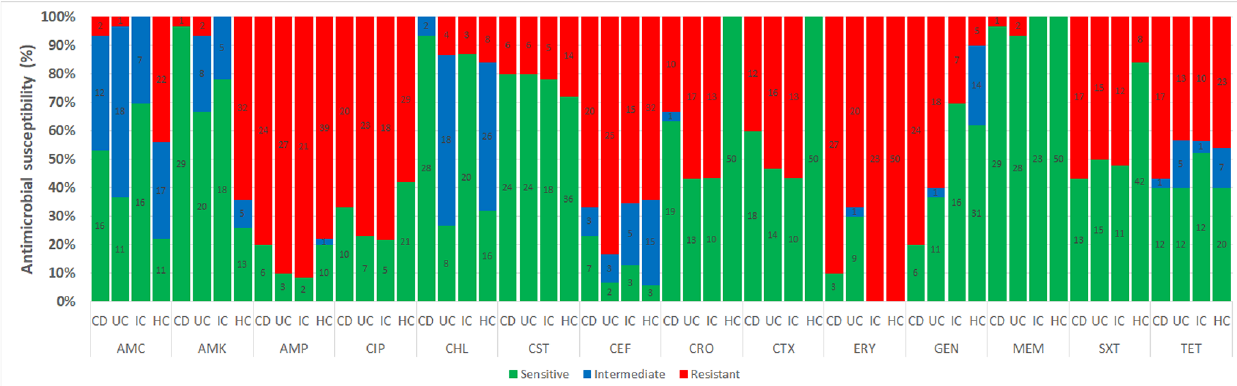
Figure 4. Antimicrobial susceptibility of 83 isolates from faecal samples of patients with CD, UC, and IC and 50 isolates from healthy controls. Number in the bar graph indicate the number of